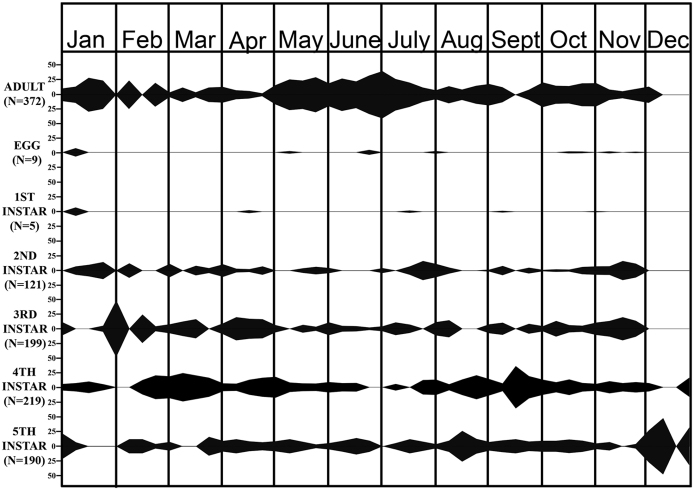
Field life cycle of M.major. Percentage in each sample of individuals of each stage collected during 2005-2007 in Las Cruces, NM. Beginning and end points of each shaded area represent sample dates preceding and following collections of specimens, respectively.